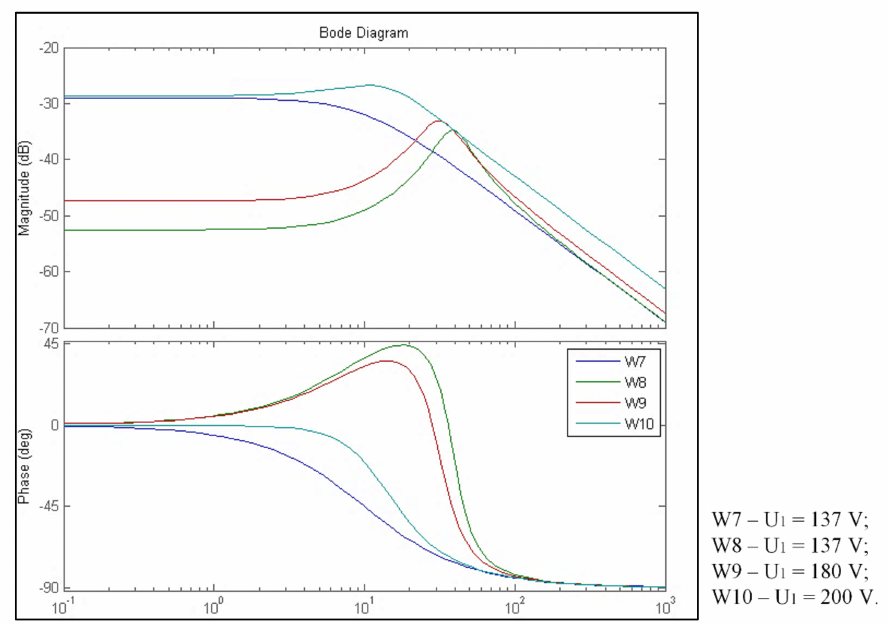
Figure 15. Frequency response and phase response of an asynchronous drive with scalar control with DPF2 at various values of stator voltage. W7—at low load; W8, W9, W10—under